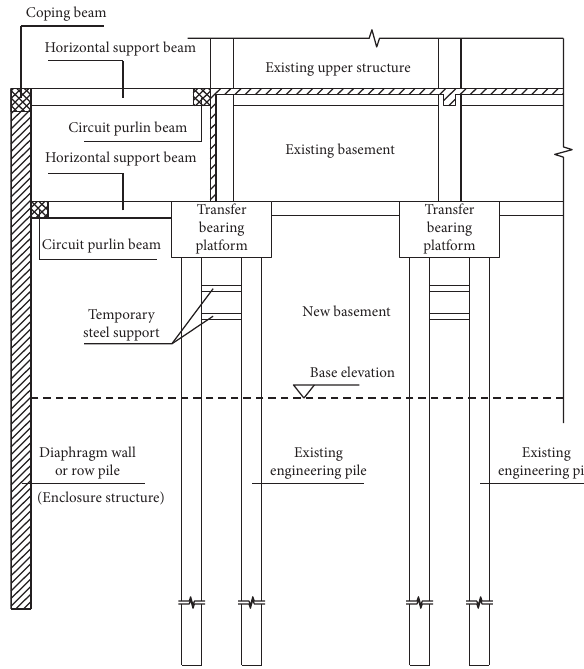
Figure 3: Vertical support section